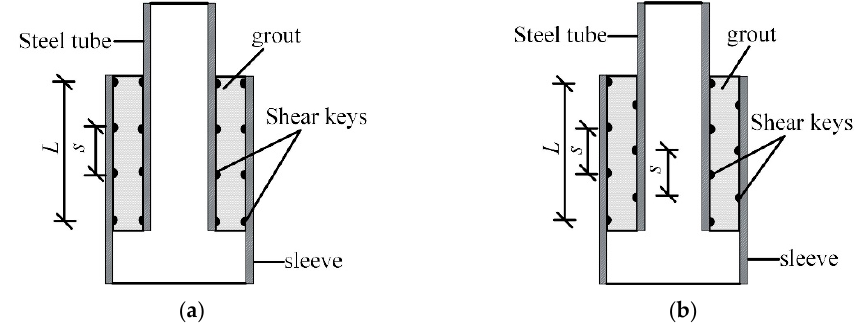
Figure 6. Layout of shear keys in sleeve grouting connection: ( a ) 60a; ( b ) B3.